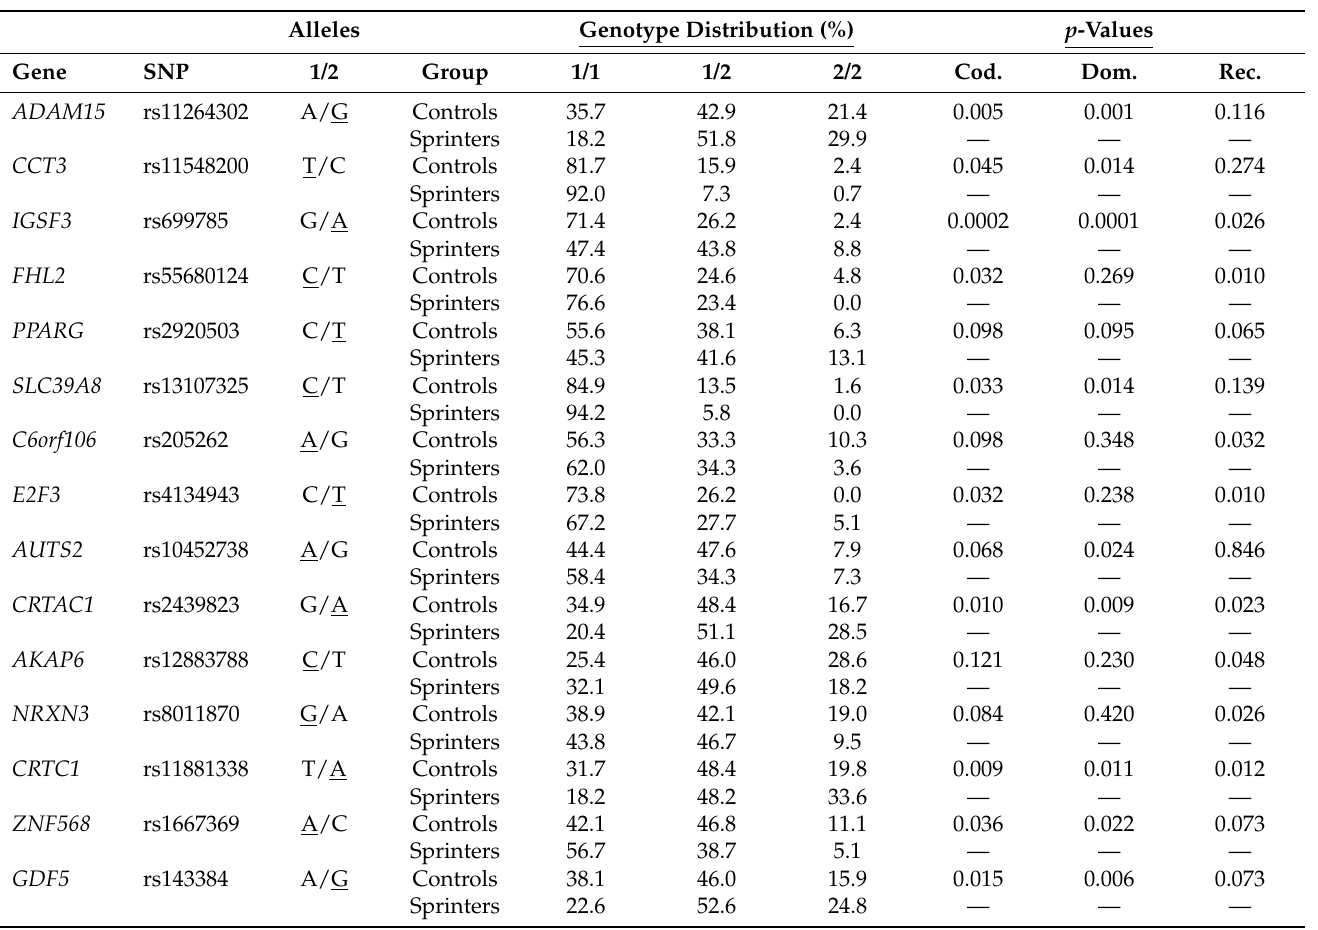
Table 2. Genotype distribution of SNPs related to self-reported walking pace associated with sprinter